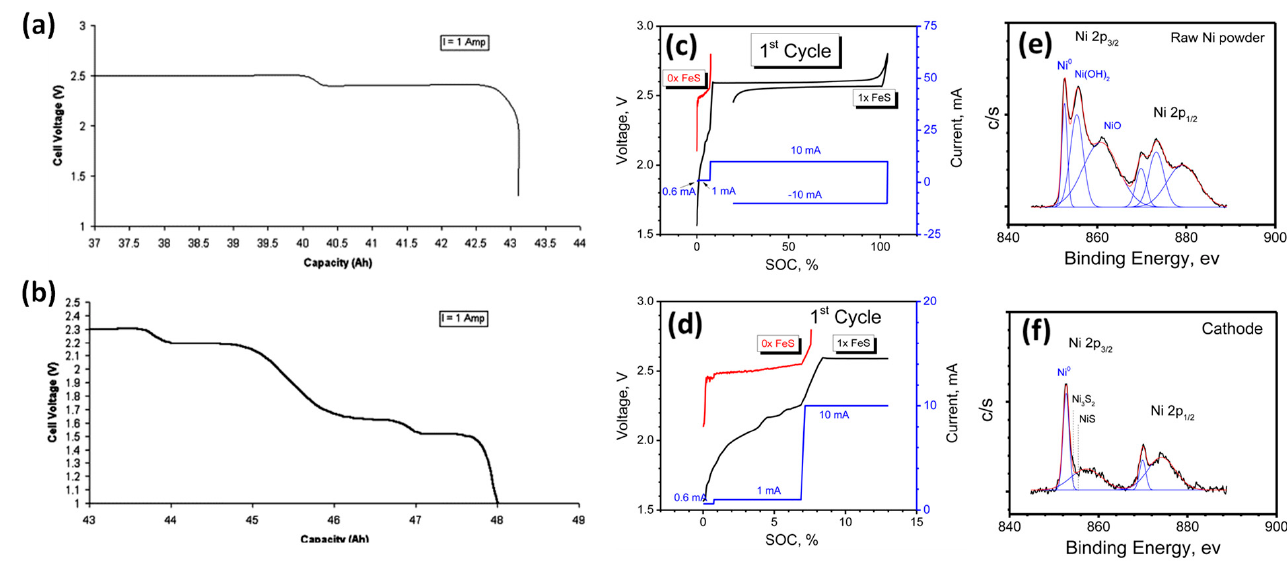
Figure 2. Voltage profiles of ( a ) first-generation and ( b ) second-generation Na-NiCl 2 cells at the end of discharge. Al and FeS powders were incorporated into the cathode of only the second-generation cell (adapted with the permission from Elsevier). ( c ) Voltage profiles (first cycle) for batteries with and without FeS. ( d ) Expanded view of panel c . High-resolution XPS Ni2p spectra for ( e ) raw Ni powder and ( f ) cathode material retrieved from cells charged up to the second step (1 mAh, 10 h, see panel c , adapted with the permission from Elsevier).